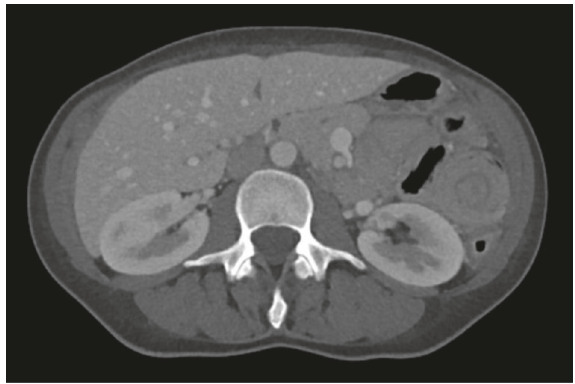
Figure 2: CT scan showing the “Target